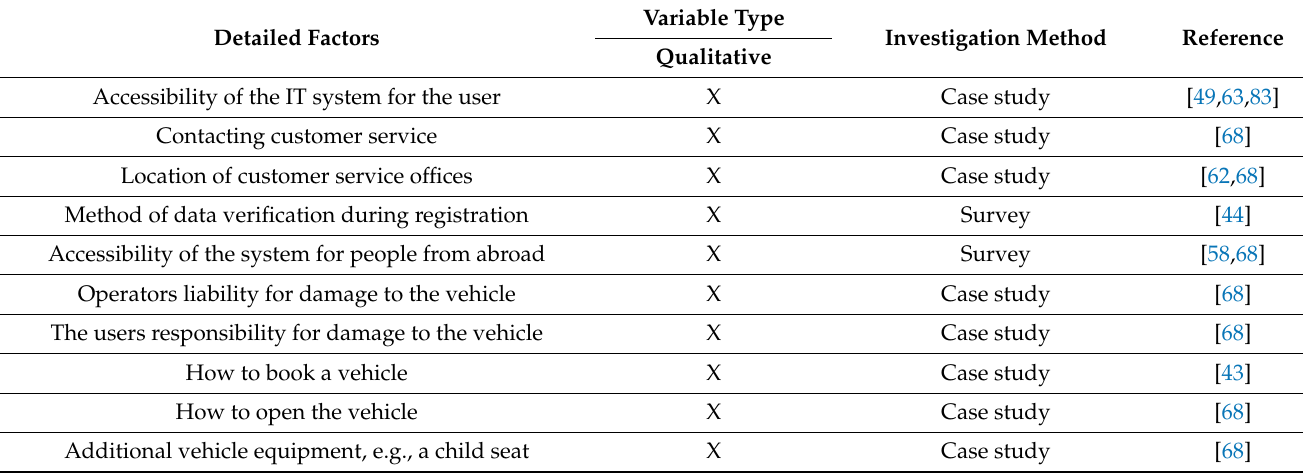
Table 13. Organizational factors of car-sharing